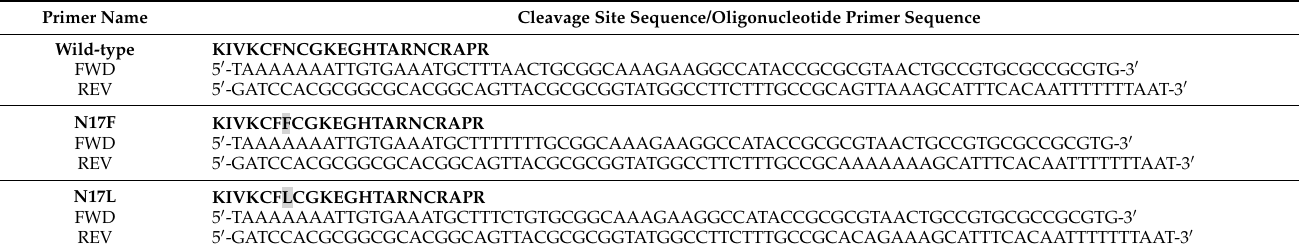
Table 1. The sequences of oligonucleotide primers used for cloning and sequencing. Amino acid sequences of HIV-1 NC-1 cleavage sites in His 6 -MBP-(GGGGS) 4 -mApple substrates are indicated above the sequences of forward (FWD) and reverse (REV) oligonucleotide primer pairs. Modified residues are highlighted with grey background in the cleavage site